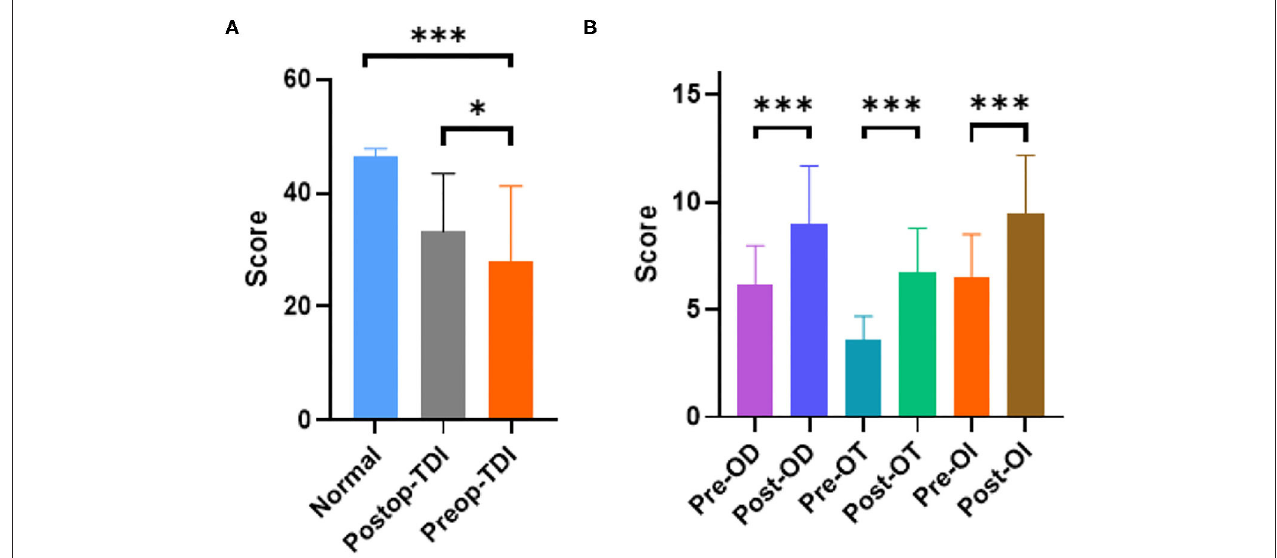
FIGURE 1 | PD patients have obvious smell disorders compared with the normal population, and DBS can improve the smell disorders in patients. (A) PD group had obvious lower TDI score ( P < 0.01 unpaired student’s t -test. Error bar = mean ± standard deviation) and DBS surgery could improve it among PD patients ( P = 0.012 paired student’s t -test. Error bar = mean ± standard deviation). (B) Different parameters (OD, OT, and OI) got improved by DBS ( P < 0.01 paired student’s t -test. Error bar = mean ± standard deviation). * p < 0.05 and *** p < 0.001.